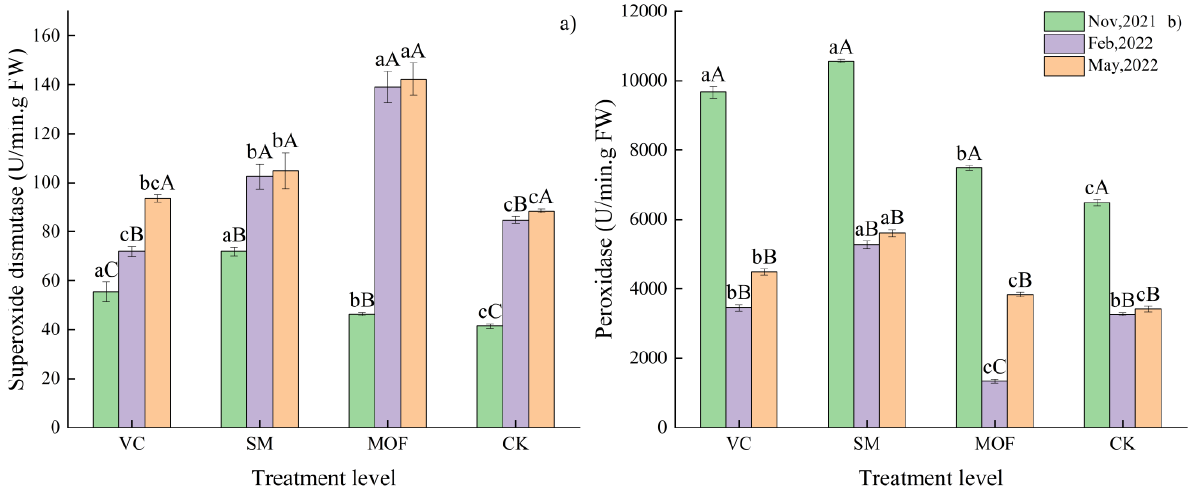
Figure 4. Effects of different bio-organic fertilizer treatments on superoxide and peroxidase activities of “Qi - Nan” agarwood seedlings. ( a ) superoxide dismutase; ( b ) peroxidase. No fertilizer (CK); vermicompost (VC); sheep manure (SM); microbial organic fertilizer (MOF). The bars were means ± standard error. Capital letters represent significant differences at the 0.05 level ( p ≤ 0.05) for the same treatment and different periods, and lowercase letters represent significant differences at the 0.05 level ( p ≤ 0.05) for the same period and different treatments.